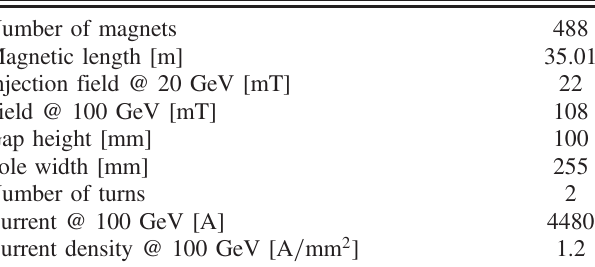
TABLE II. Main parameters of the LEP main bending magnets.